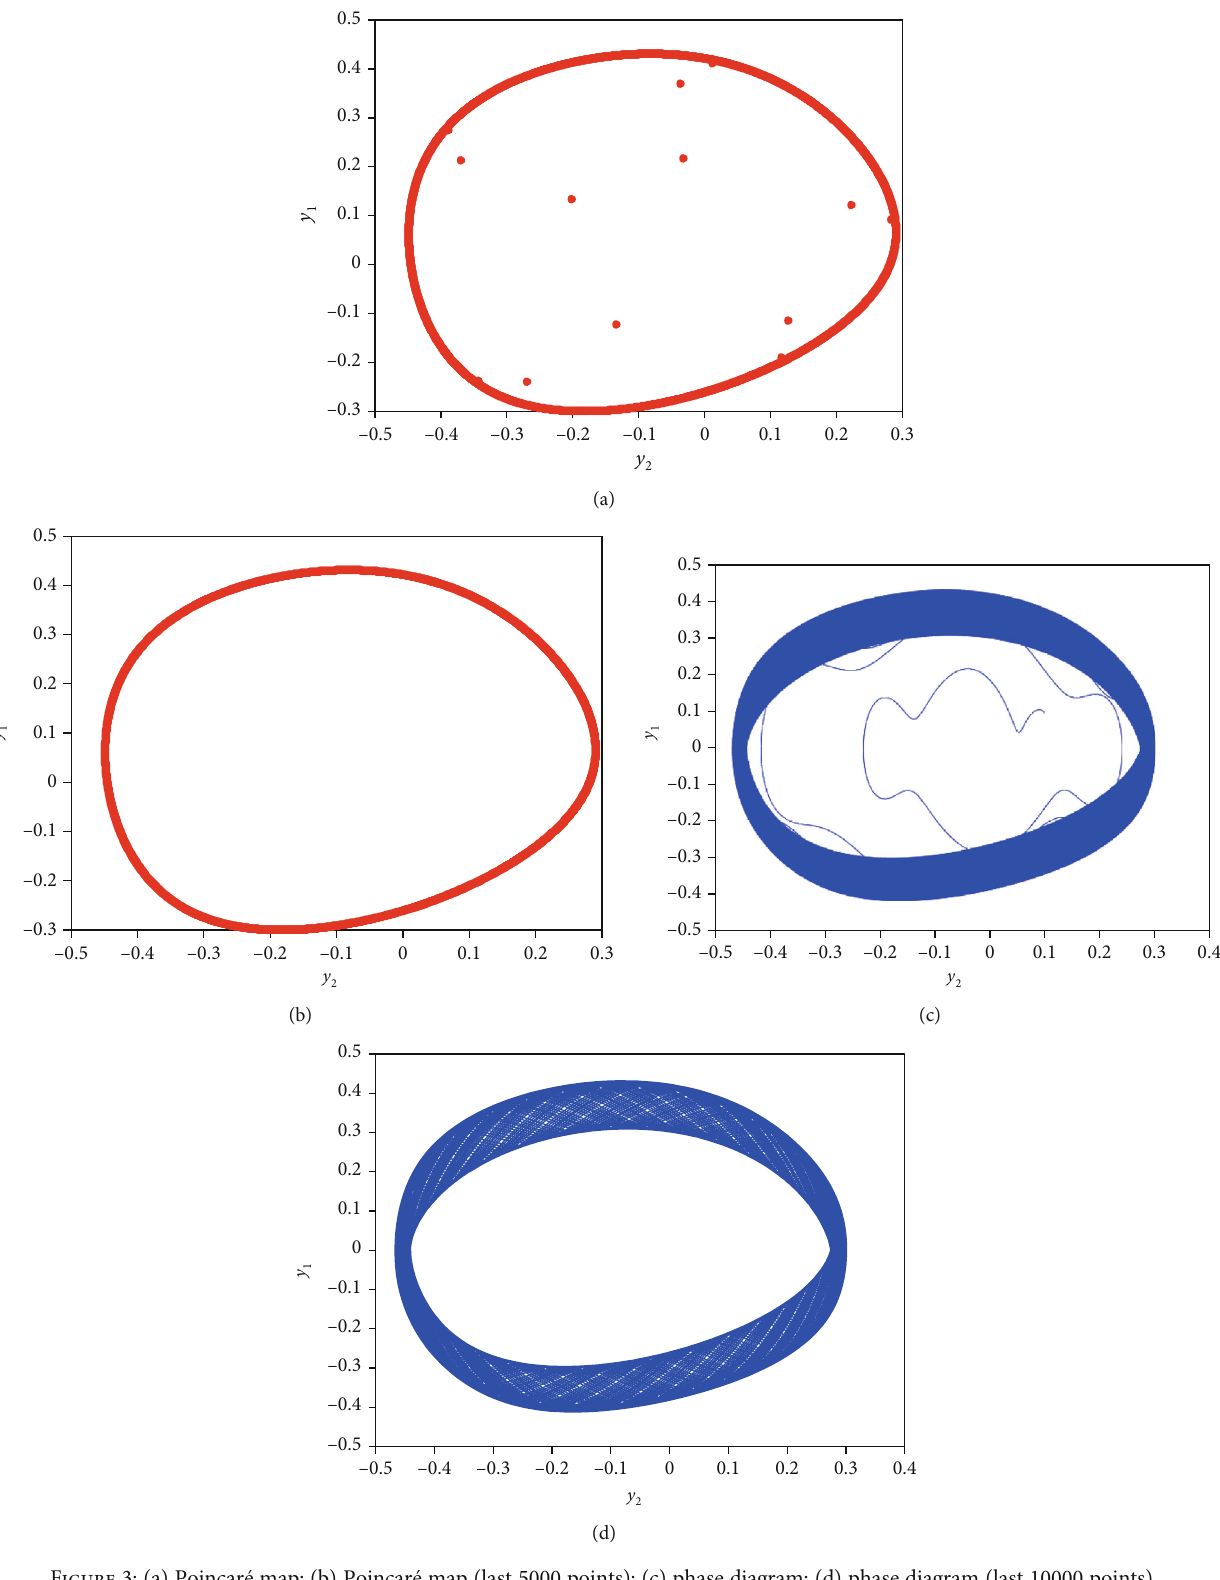
Figure 3: (a) Poincaré map; (b) Poincaré map (last 5000 points); (c) phase diagram; (d) phase diagram (last 10000